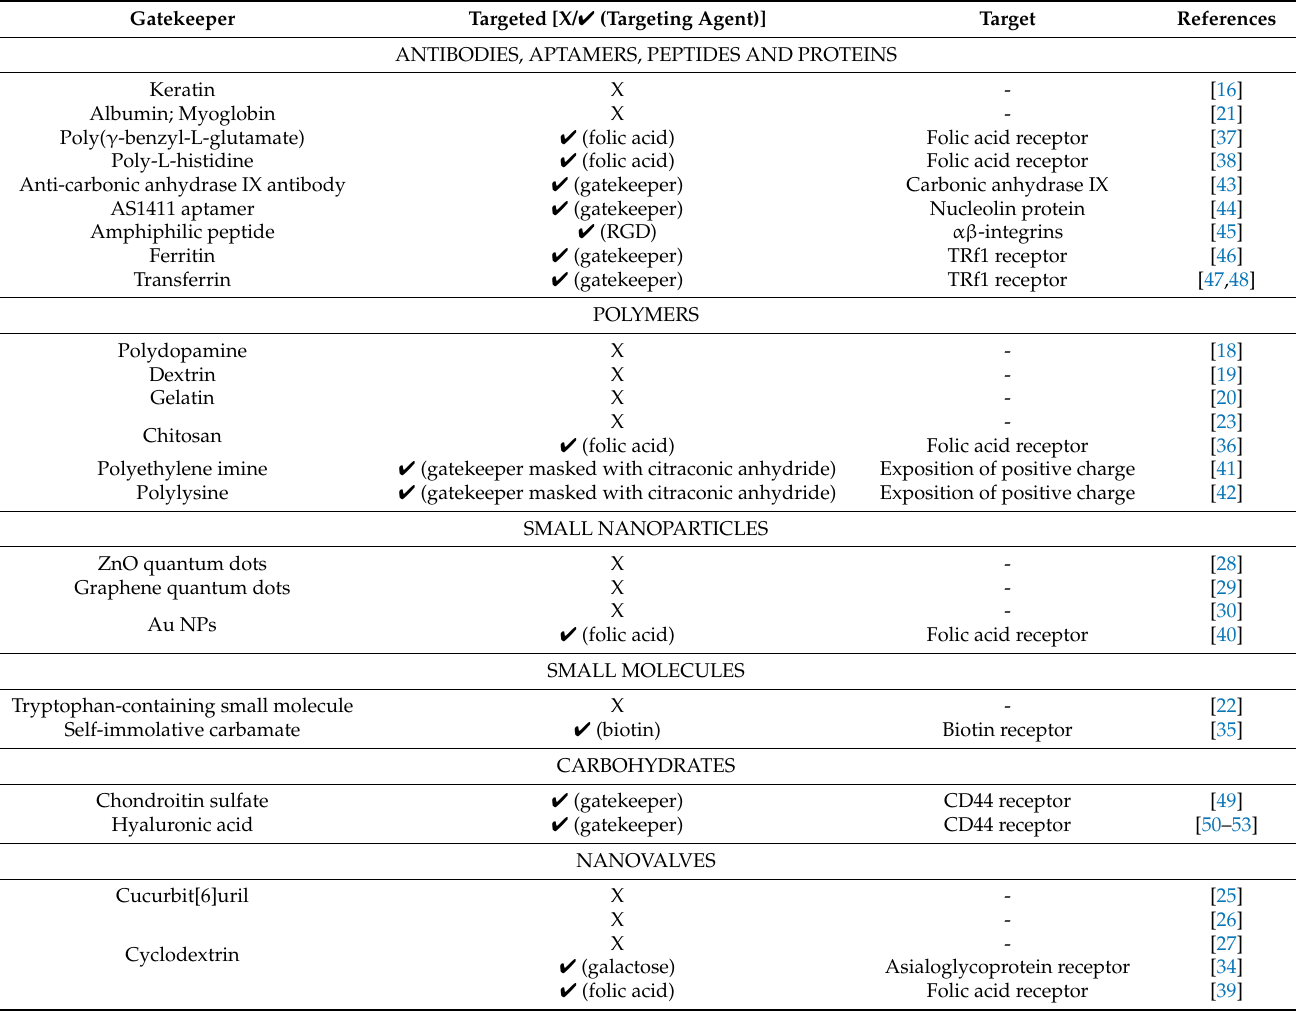
Table 1. Summary of the different gatekeepers described in the previous sections and whether they are targeted.